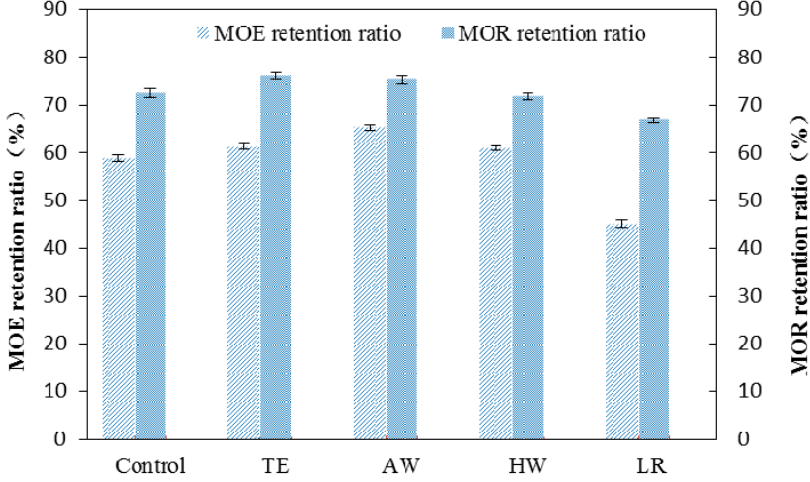
Figure 6. The MOE and MOR retention ratios of the WPCs reinforced with extracted or delignified Figure 5. The MOE and MOR of the WPCs reinforced with extracted or delignified WF. WF.